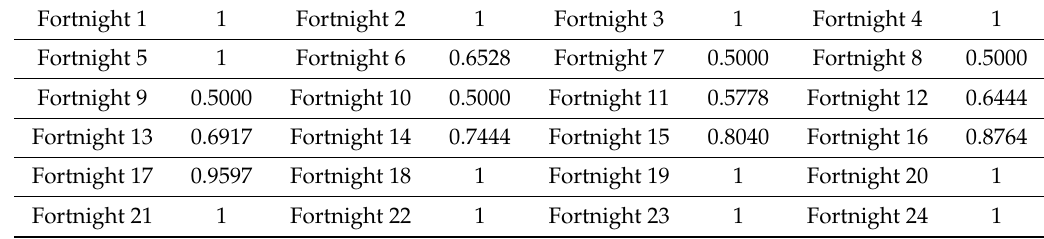
( ) β 0 N is constrained to the interval